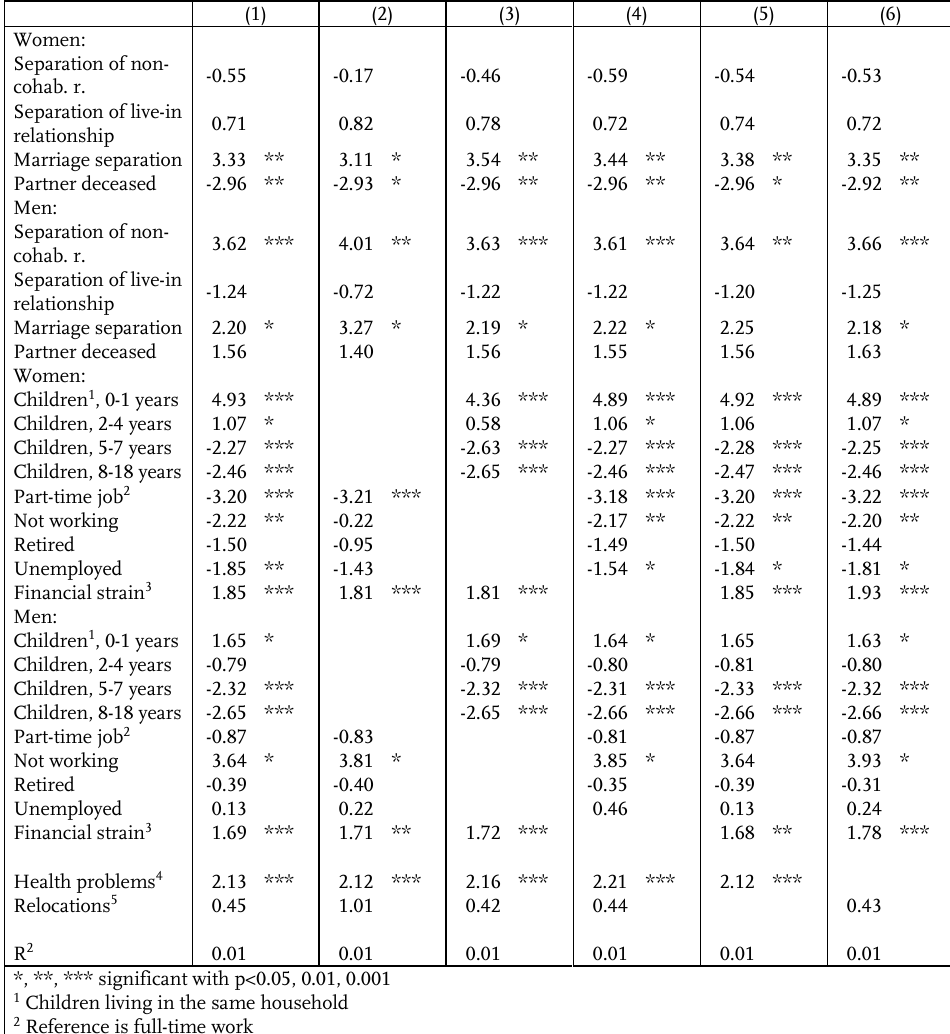
Table A.10 : Effects of relationship endings, children, employment, financial strain, relocations, and health on absence of tertiary-sphere contacts (non-participation in clubs and civil organizations; linear- probability models with fixed effects, percentage